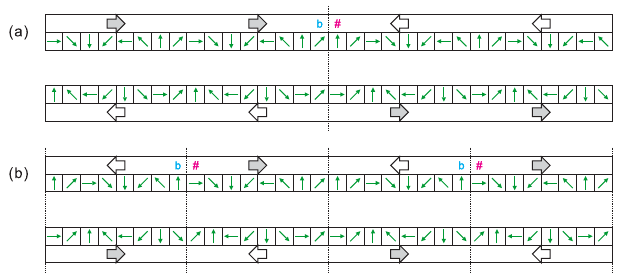
FIG. 9. Conceptual drawing of PCU which has eight magnets per period ( M ¼ 8 ) for (a) D ¼ 2 and (b) D ¼ N